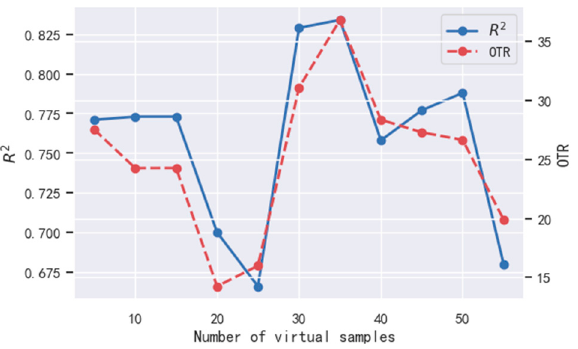
Figure 6. Under different numbers of virtual samples, the R 2 value and OTR values of the ultrasound evaluation model.